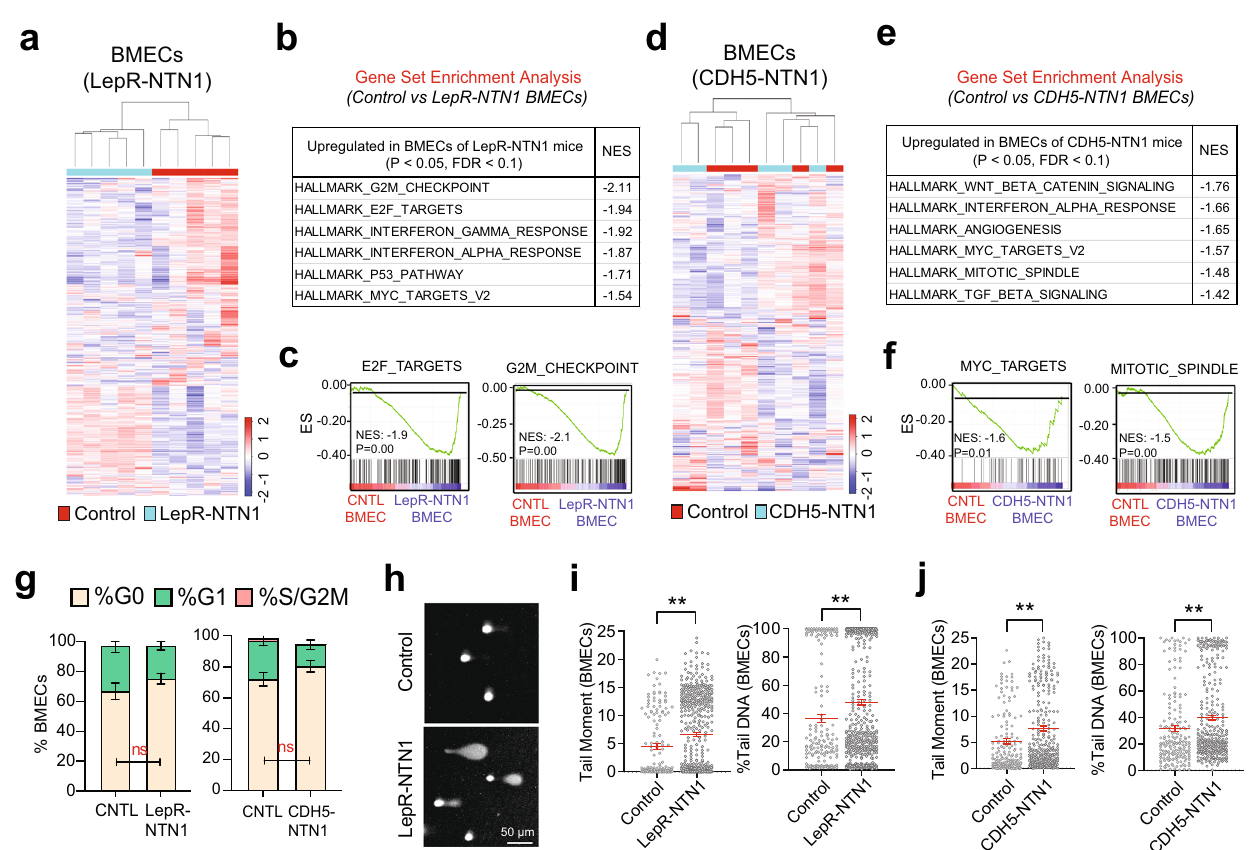
Fig. 5| LossofNTN1 causesDNAdamagewithinBMECs.a – c RNA-Seq analysisof BMECsderived from young (5-6month-old) LepR-NTN1 mice. a Heatmapdepicting hierarchical clustering of differentially expressed genes. b GSEA demonstrating activationofDDRpathwaysinBMECsof LepR-NTN1 mice. c GSEAEnrichmentplots demonstrating activation of E2F_TARGETS and G2M_CHECKPOINT pathways in BMECs of LepR-NTN1 mice. d – f RNA-Seq analysis of BMECs derived from CDH5- NTN1 mice. d Heatmapdepicting hierarchicalclustering ofdifferentiallyexpressed genes. e GSEA demonstrating activation of DDRpathways in BMECs of CDH5-NTN1 mice. f GSEA Enrichment plots demonstrating activation of MYC_TARGETS and MITOTIC_SPINDLE pathways in BMECs of CDH5-NTN1 mice. g Cell-cycle analysis